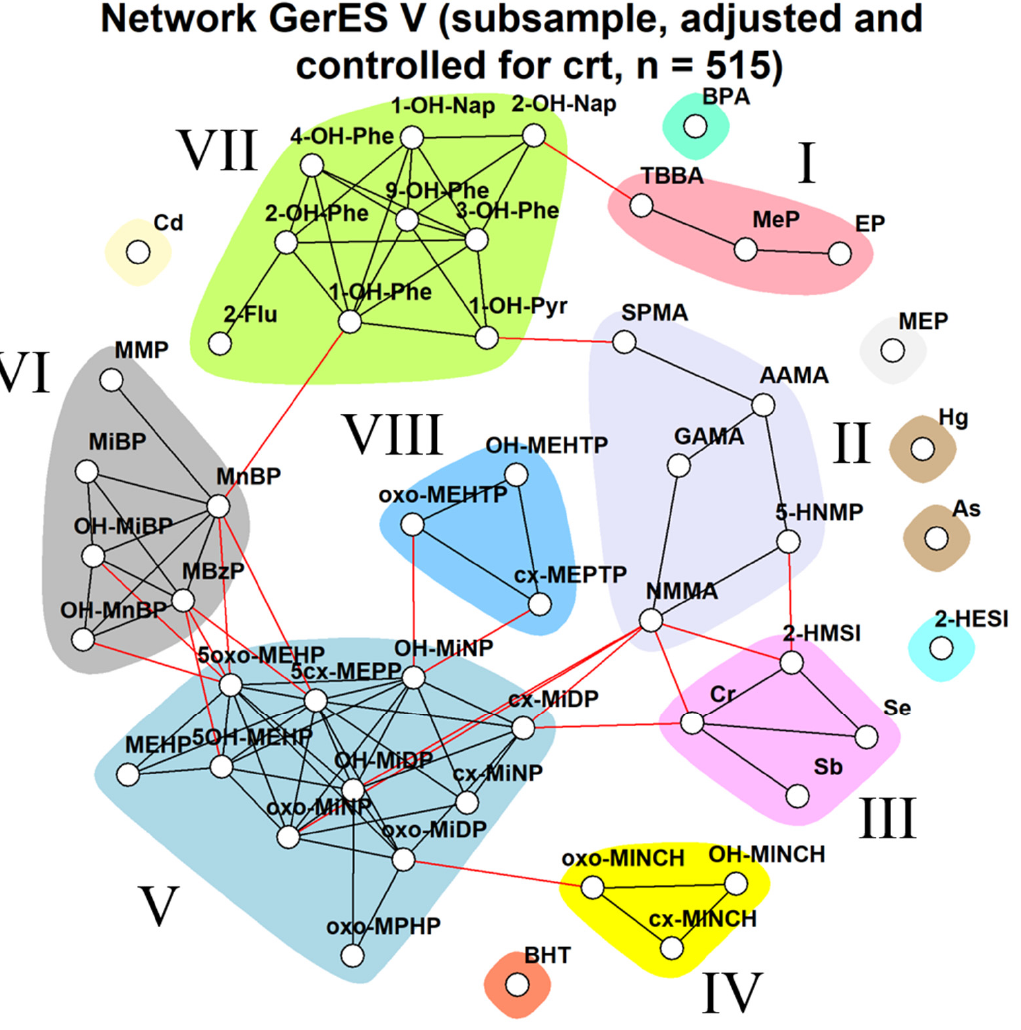
Figure A3. Network of GerES V subset, using creatinine-standardised and creatinine-adjusted data. Black lines indicate dependency between nodes (biomarkers) within a community; red lines indicate dependency between nodes in different communities.